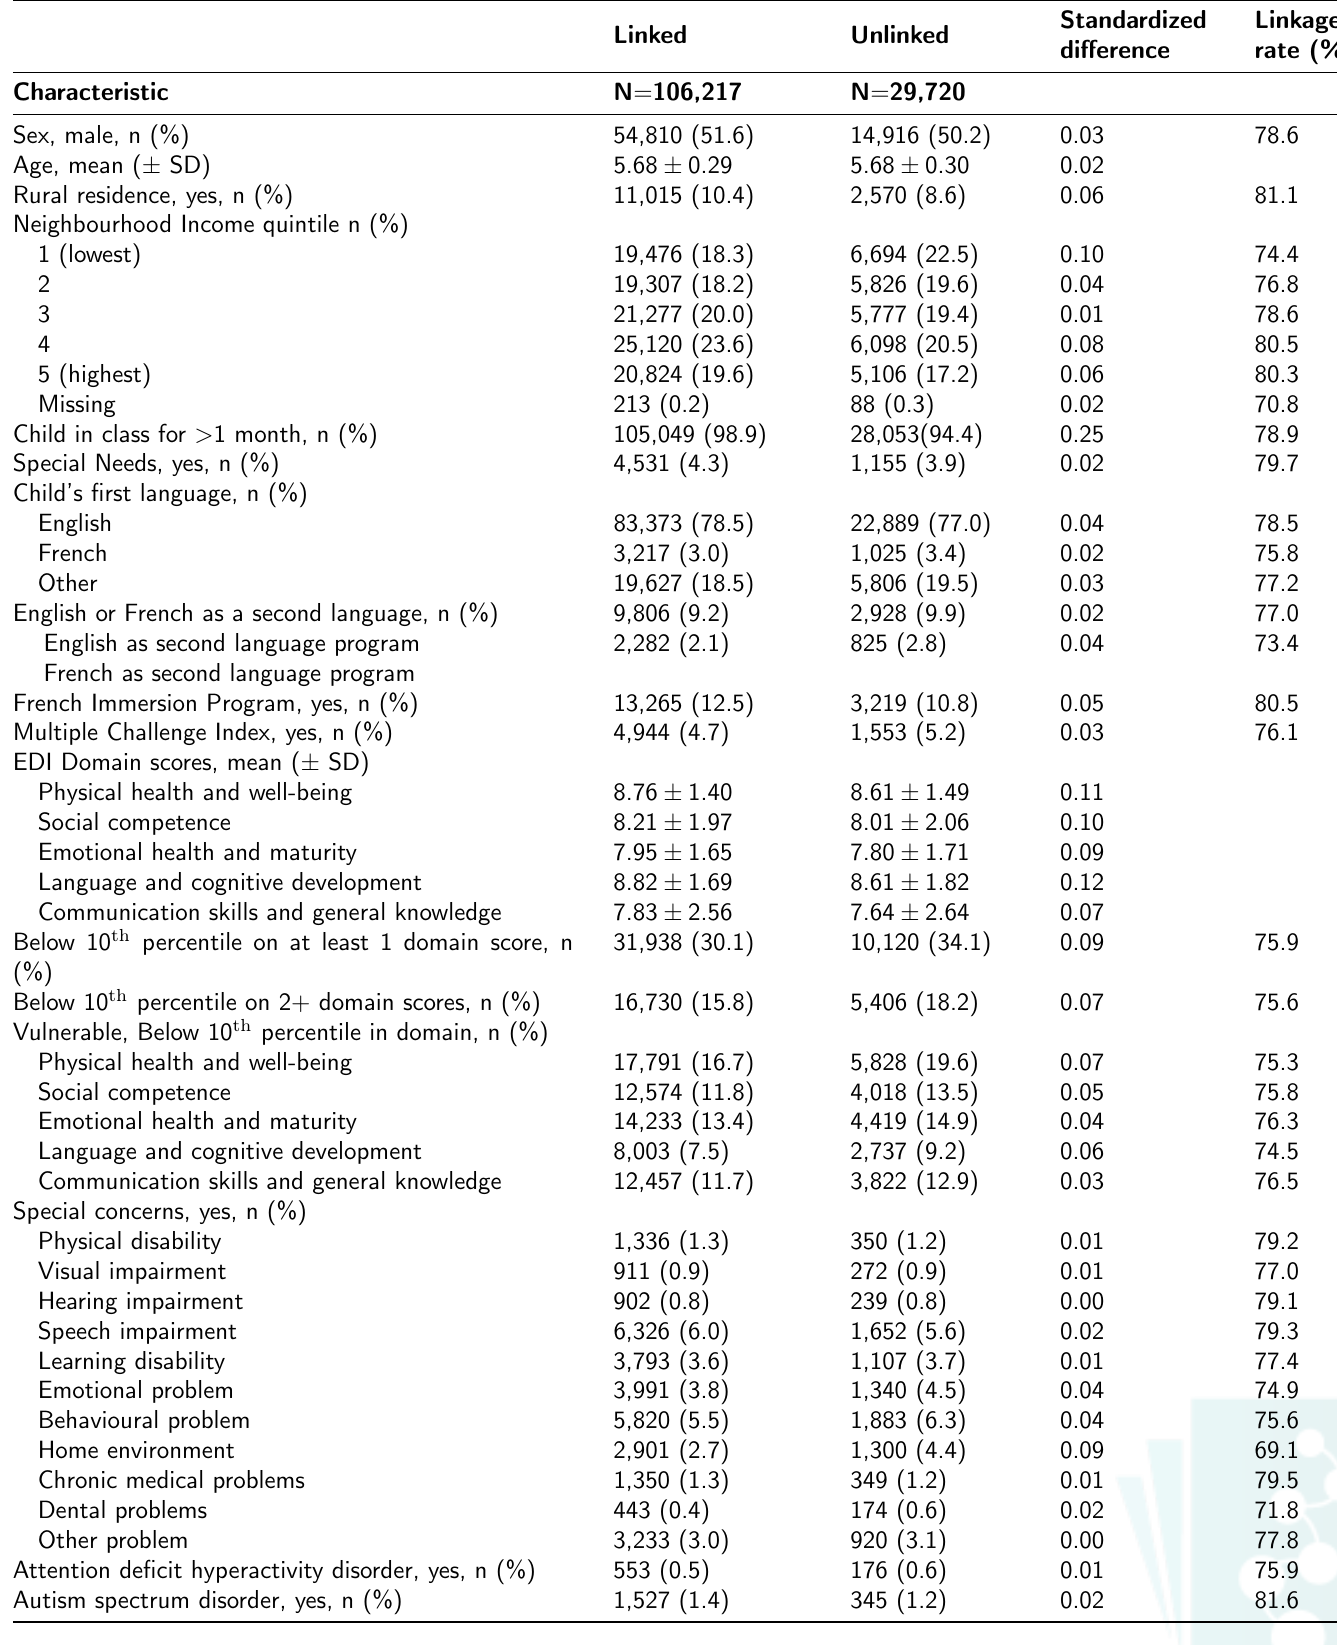
Table 1: Characteristics of children with linked and unlinked early development instrument records Linked Unlinked